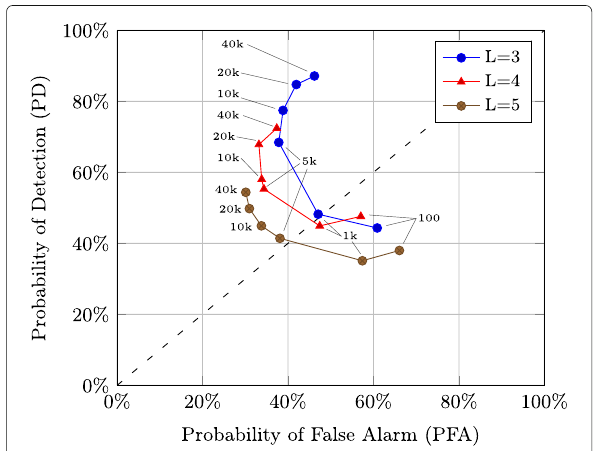
Fig. 11 Morwilog execution time vs. number of events in E in . Each point is the average of the result of 50 simulations with the parameters in Table 2